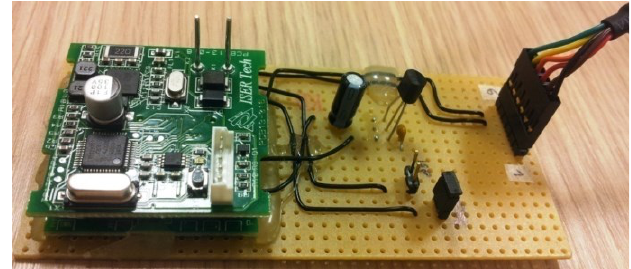
Fig. 11. Prototype of the control board